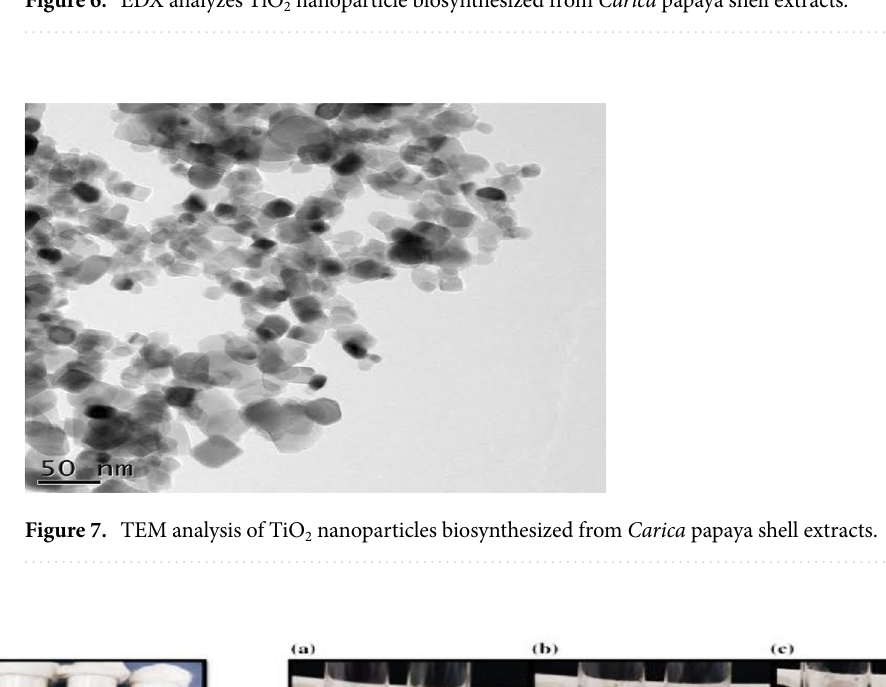
Figure 6. EDX analyzes TiO 2 nanoparticle biosynthesized from Carica papaya shell extracts.